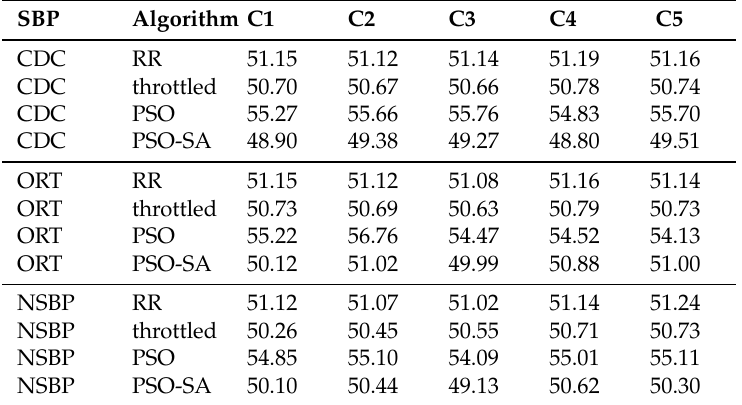
Table 3. Average RT (ms) of Scenario